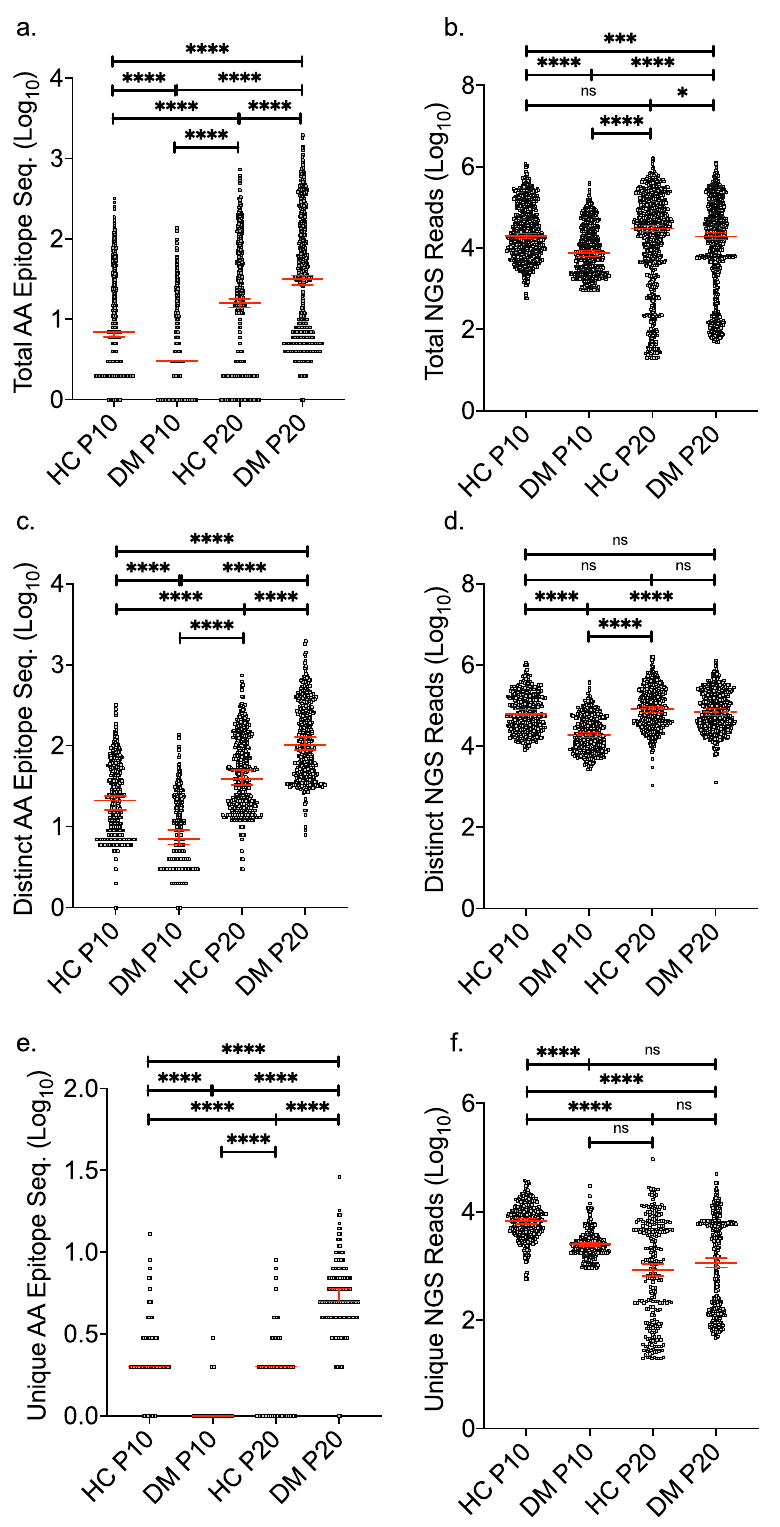
Fig. 2 Microbial amino acid epitopes and their abundance in dermatomyositis and healthy controls. The number of different epitopes per microbial species (left panel) and the number of next-generation sequencing (NGS) reads that mapped to these epitopes (right panel) are depicted; a Total number of microbial amino acid (AA) epitopes, b microbial NGS reads, c number of distinct AA epitopes, d distinct microbial NGS reads, e number of unique AA epitopes and f unique microbial NGS reads. All values were log 10 transformed. Dunn ’ s multiple comparisons test was used to test speci fi c sample pairs. Differences were signi fi cant at the 0.05 level; *for p < 0.05, **for p < 0.01, ***for p < 0.001, etc. DM dermatomyositis, HC healthy controls, ns not- signi fi cant, P10 pool of 10, P20 pool of 20. The median with 95% CI is